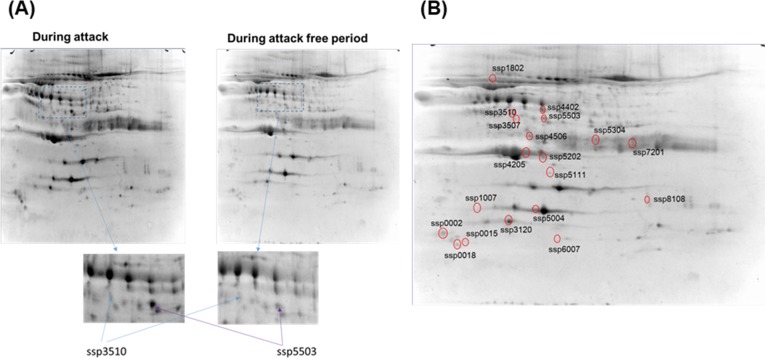
Representative two-dimensional electrophoresis analysis of samples collected during migraine attacks.Gel images are shown for samples from migraine attack and attack-free periods after analysis and normalization using PDQuest software. The arrows on the spots with identical spot numbers across gels indicate proteins at the same gel positions. (A) Representative spot ssp3510 contained APOE, complement factor B, and albumin, ssp5503 contained transthyretin, APOE, albumin, and serum amyloid P-component. (B) 19 spots obtained from the attack period gel showed over 3-fold differences in densitometric volumes in the attack period gel compared with those in the attack free period gel (Table 2).